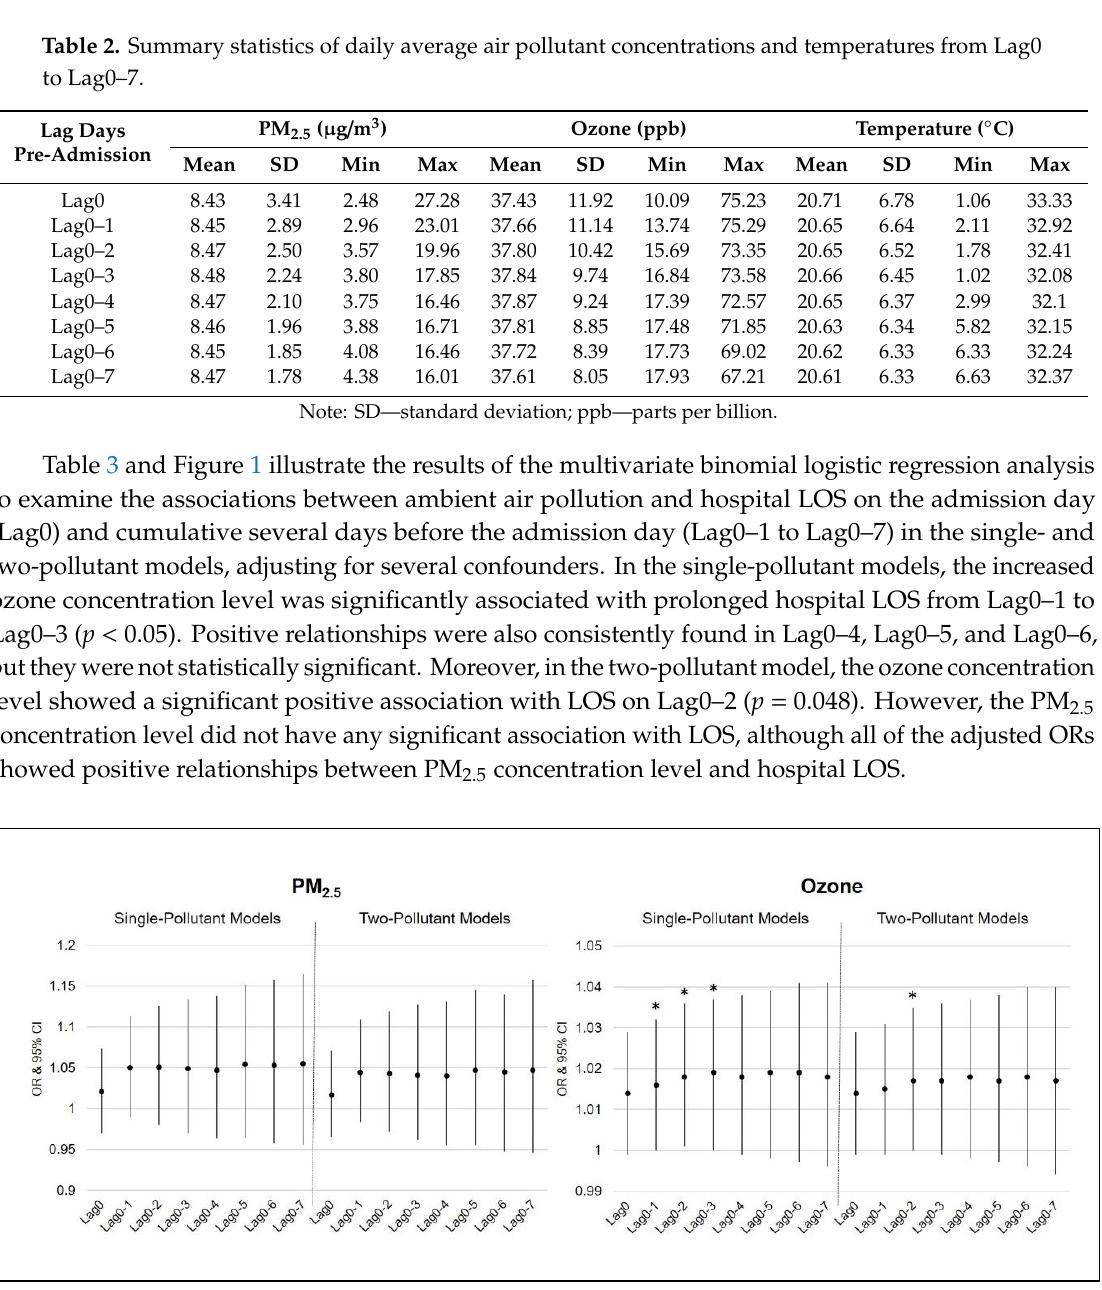
Figure 1. Lag structures of the odds ratio (OR) and 95% confidence interval (CI) of PM 2.5 and ozone with hospital length of stay in single-pollutant and two-pollutant models. Note: OR — odds ratio; 95% CI — 95% confidence interval; * p < 0.05.